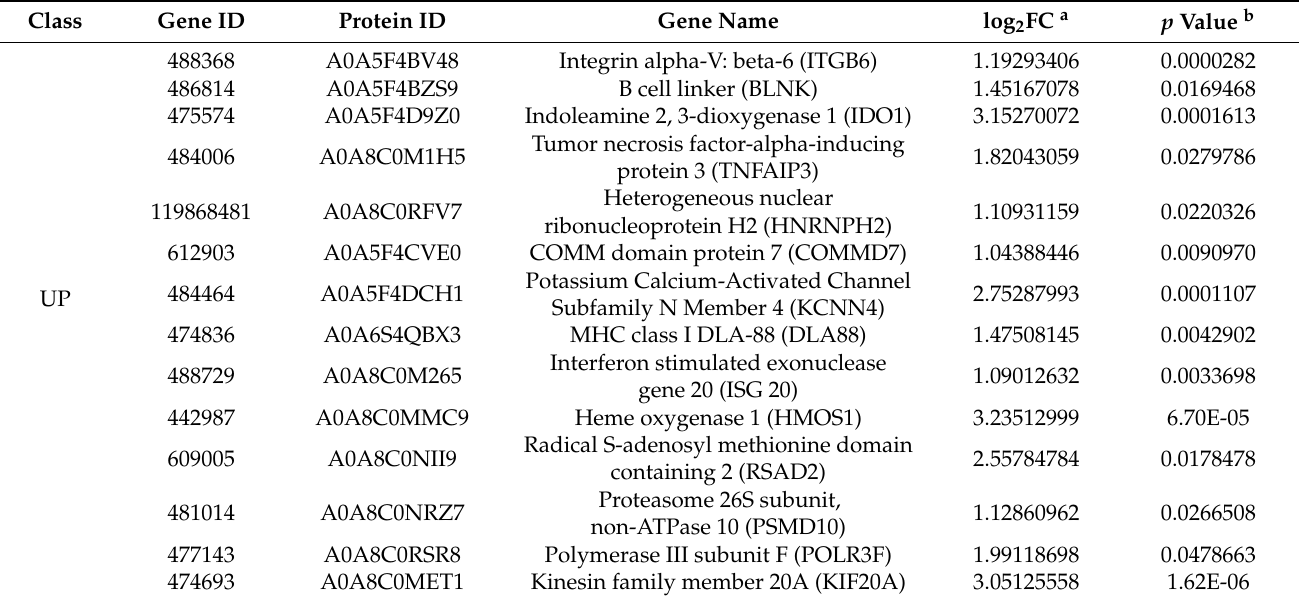
Figure 3 . Validation of mRNA expression. A: Proteins were found to be differentially expressed between uninfected MDCK mock and infected MDCK H1N1 16 hpi cells based on proteomics screening. Of these proteins, 23 are involved in regulation of the host antiviral innate immune response. qPCR was used to validate these proteomics results at the mRNA level, using the 2 −ΔΔCt method and GAPDH as the internal reference gene. * Was used to determine statistically significant differences between groups; * p < 0.05, ** p < 0.01, *** p < 0.001, **** p < 0.0001. Table 1 . Expression of significantly changed immune-response-related proteins in MDCK cells after influenza virus H1N1 infection.